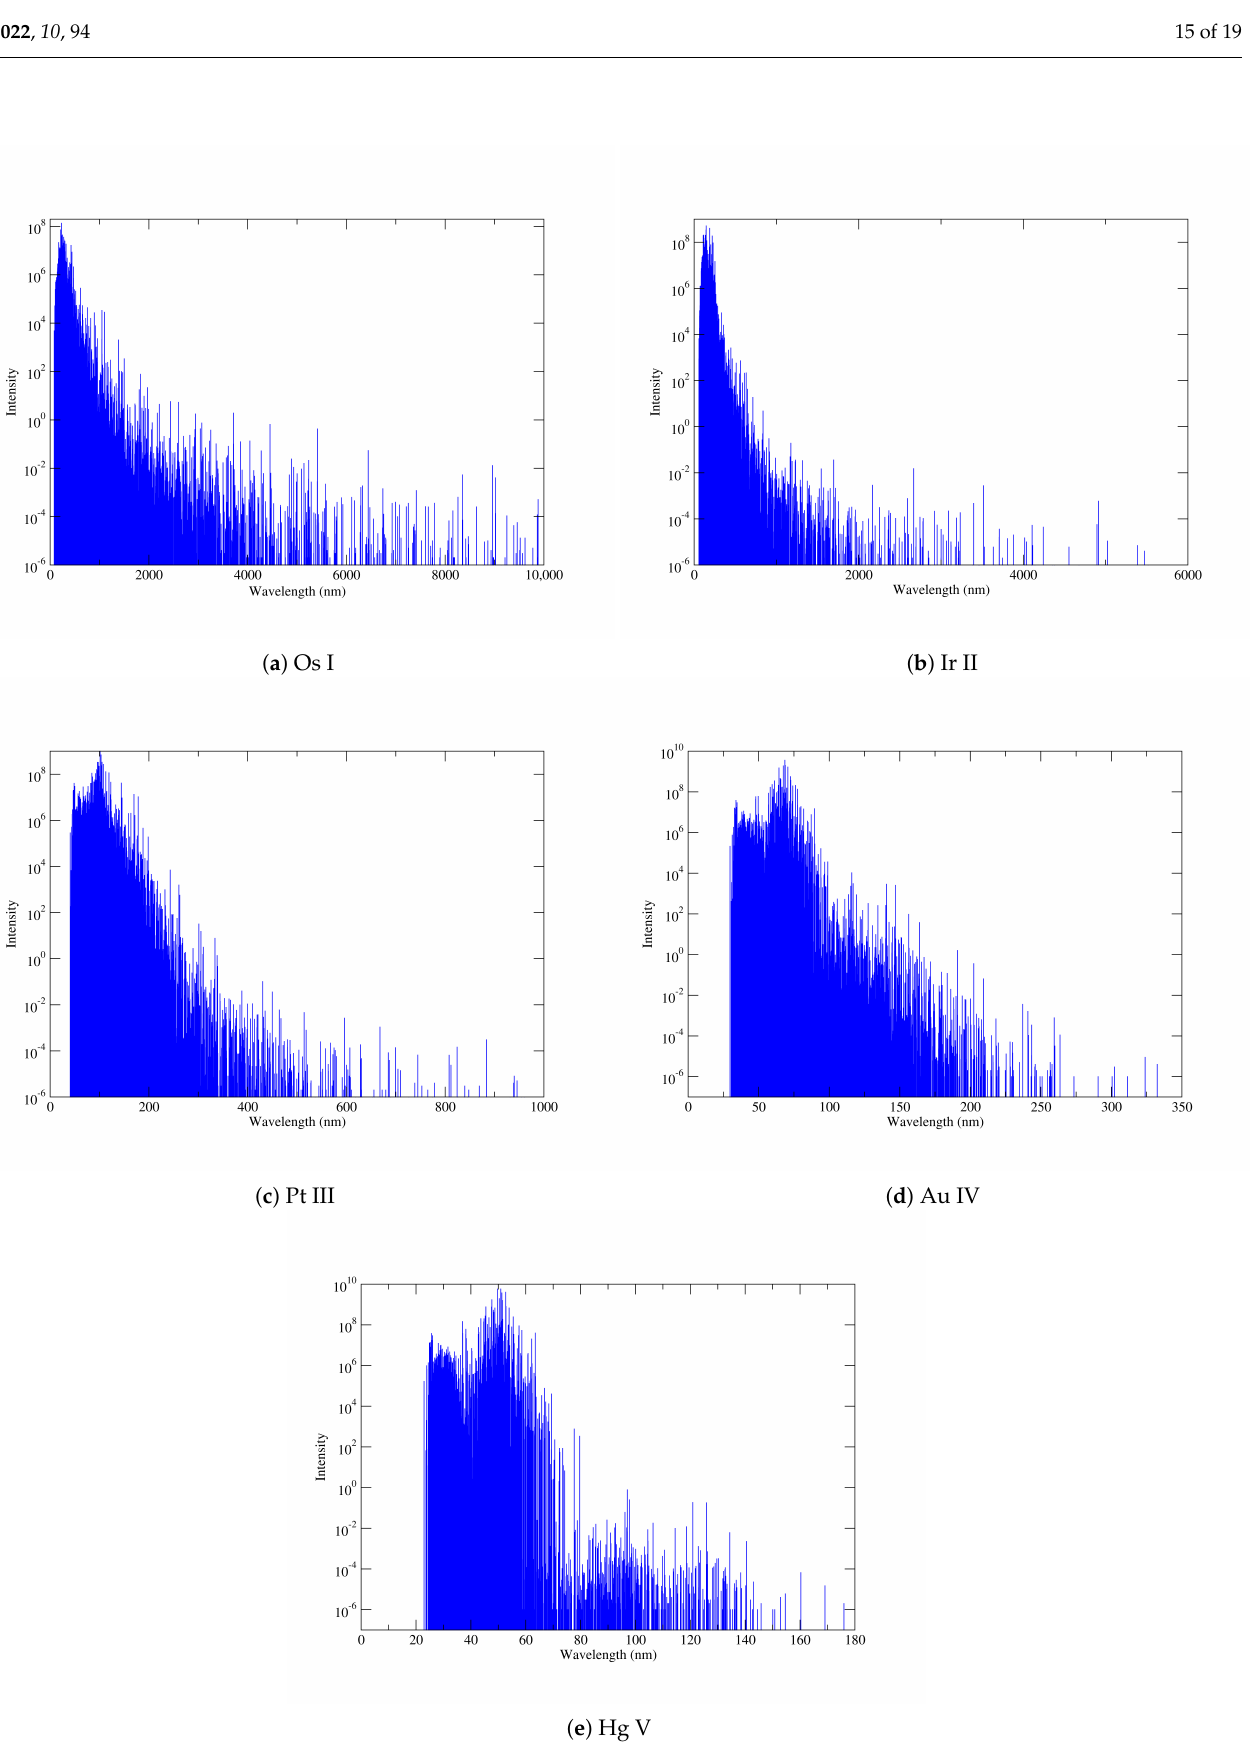
Figure 4. LTE spectra at T = 5000 K for ( a ) Os I, ( b ) Ir II, ( c ) Pt III, ( d ) Au IV, and ( e ) Hg V obtained from GRASP2K calculations. The intensity is given in arbitrary